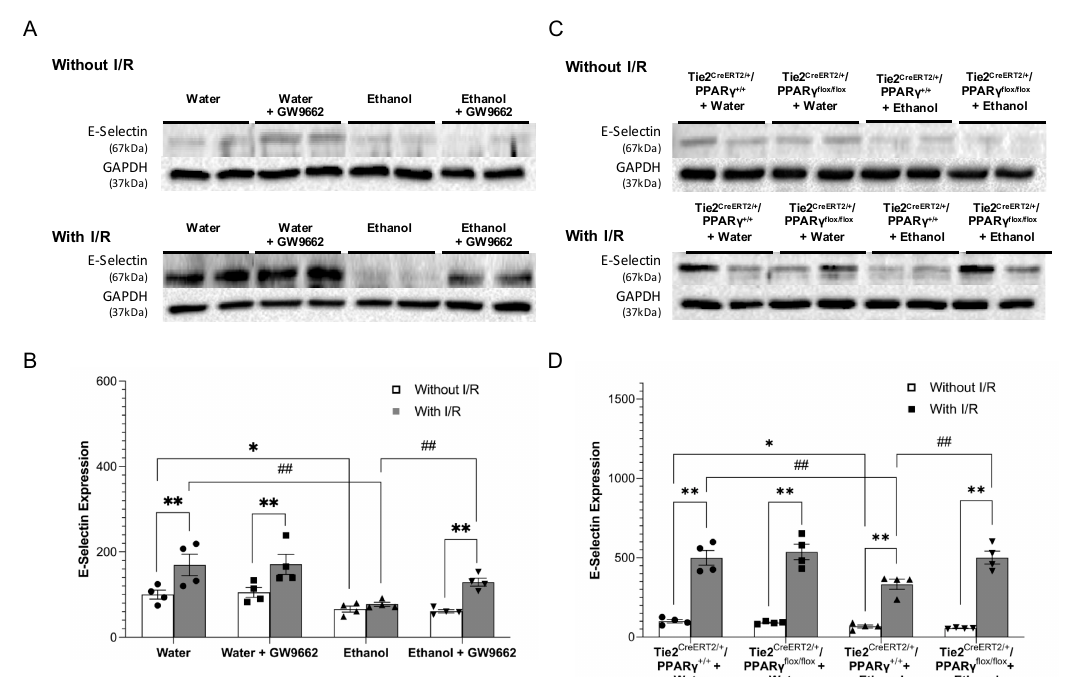
Figure 4. Effect of chronic ethanol consumption on E-selectin expression of the cerebral cortex in the presence and absence of GW9662 and endothelial-specific conditional PPAR γ knockout. ( A , C ) Representative Western blots. ( B , D ) Values are means ± SE. * p < 0.05 vs. Water or Tie2 CreERT2/+ /PPAR γ +/+ + Water. ** p < 0.05 vs. Without I/R. ## p < 0.05 vs. Ethanol or Tie2 CreERT2/+ /PPAR γ +/+ + Ethanol. Analyzed using two-way ANOVA with Tukey’s post hoc.